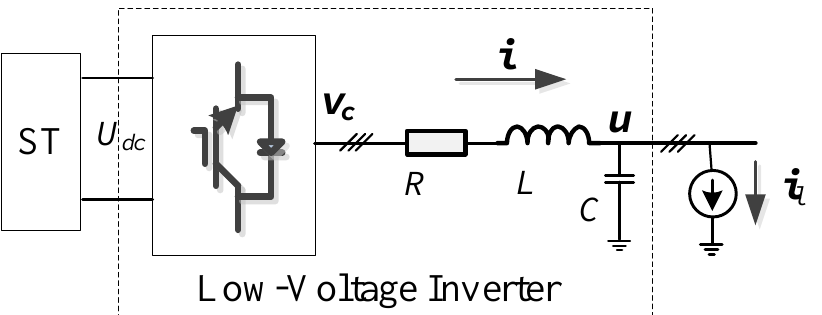
Figure 1. Structure of the simple inverter system.